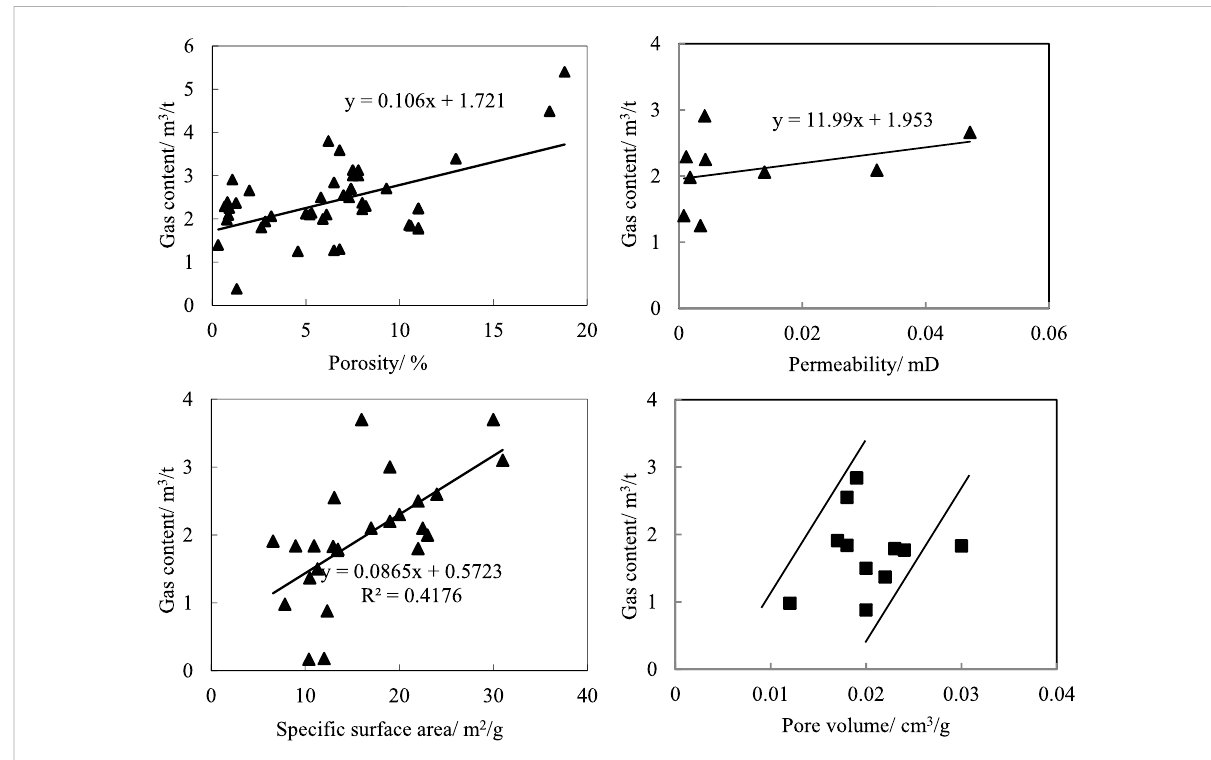
FIGURE 15 Relationships between gas content versus porosity (upper left), permeability (upper right), speci fi c surface area (lower left) and pore volume (lower